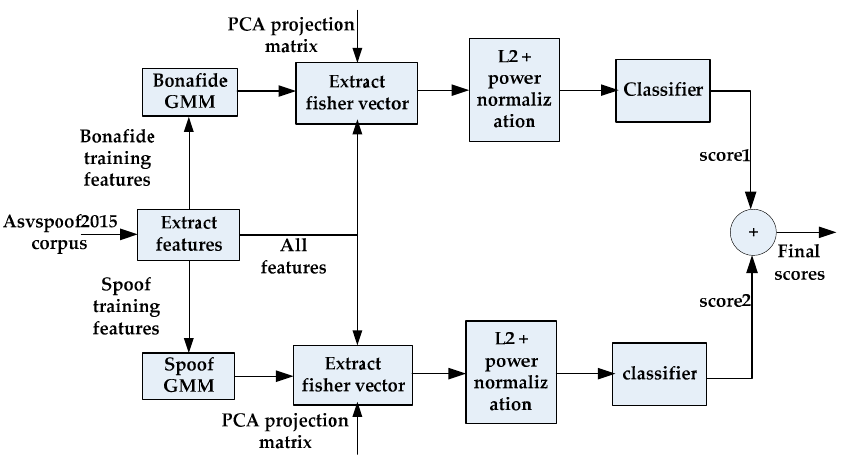
Figure 4. Schematic diagram showing various steps of Fisher vector encoding based spoofing detection systems. This approach is comprised of two sub-systems based on two Gaussian mixture models (GMMs) trained on bonafide and spoof training data, respectively. Here, principal component analysis (PCA) projection matrix is trained on the training.